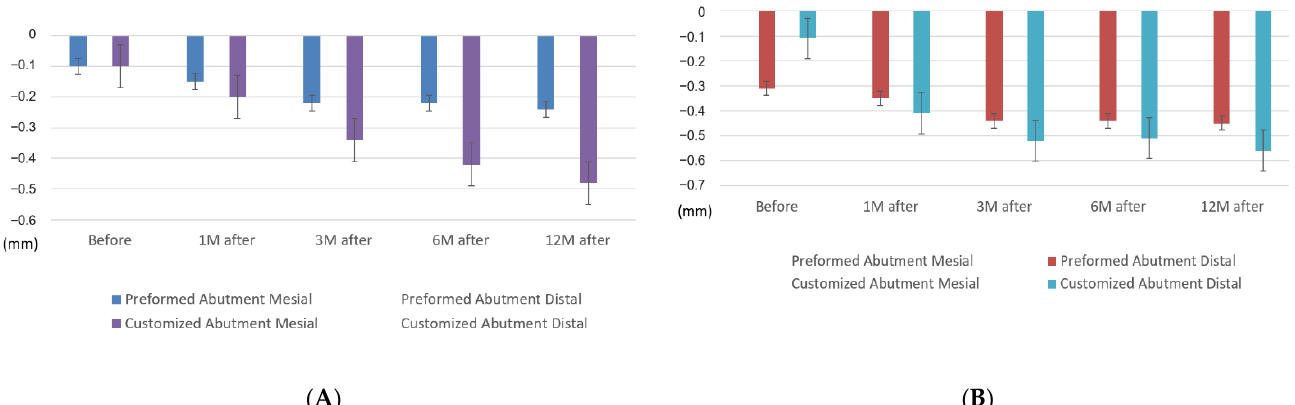
Figure 4. Comparison of the mesial marginal bone levels between the CAs and PAs ( A ) and the distal marginal bone levels ( B ). CA, customized abutment; PA, preformed stock abutment.